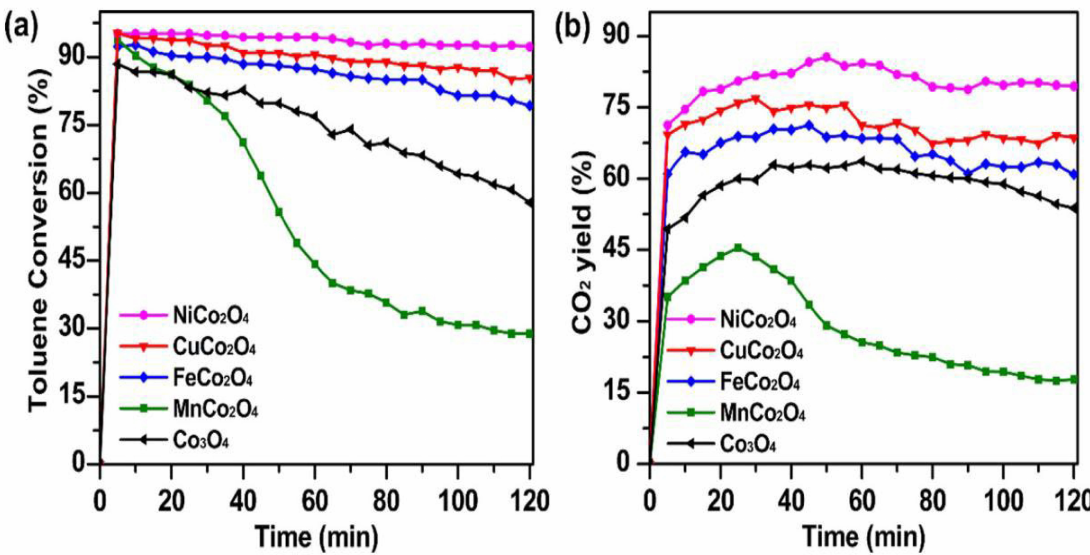
Figure 3. Toluene conversion ( a ) and CO 2 yield ( b ) over the catalysts under the irradiation (simulated sunlight, 400 mW/cm 2 ). Reproduced with permission from Ref. [94]. Copyright 2019 Xi